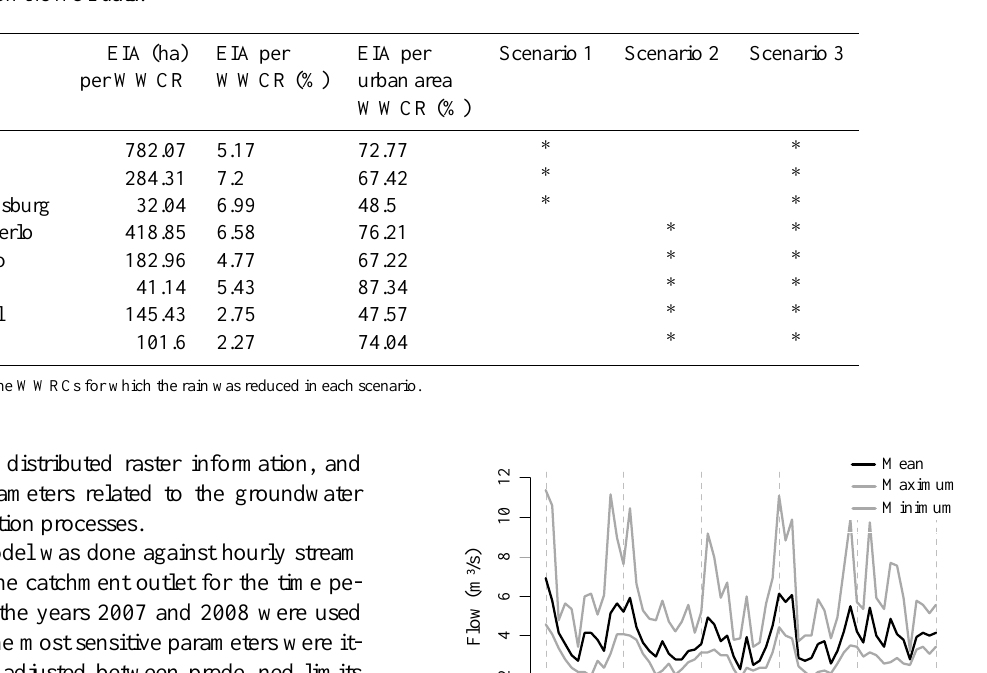
Table 3. Different variables used to implement the reduced rain scenarios: EIA in the catchment (ha), EIA per WWCR (%) and EIA per urban area unit (%) based on the NGI data.